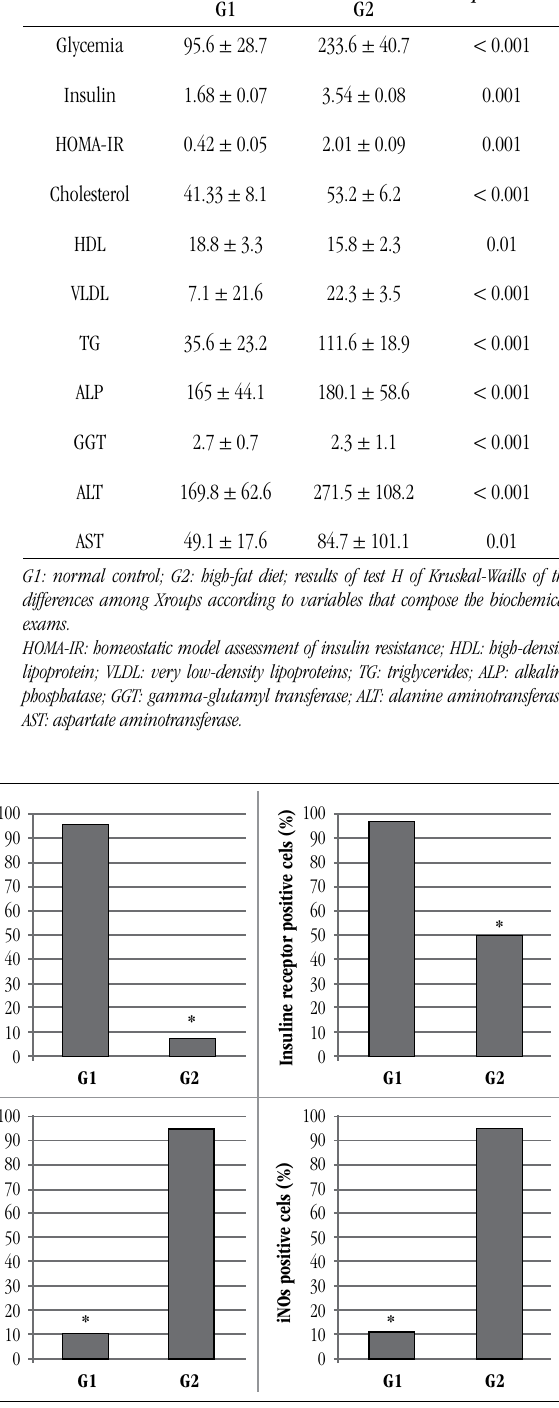
figurE 2 – Positivity for immunoexpression of adiponectin, insulin receptor, TNF- α and iNOS in control group (G1) and group on the high-fat diet (G2)